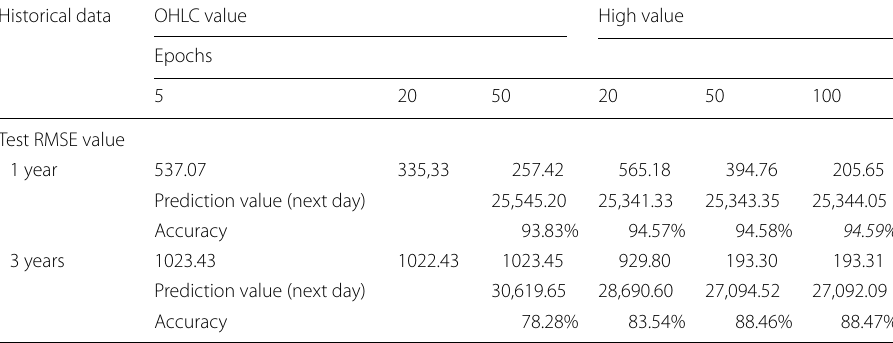
Table 1 Result of experiment with various historical data and epoch (with epoch 100 in 1 year, the best accuracy 94.59% is